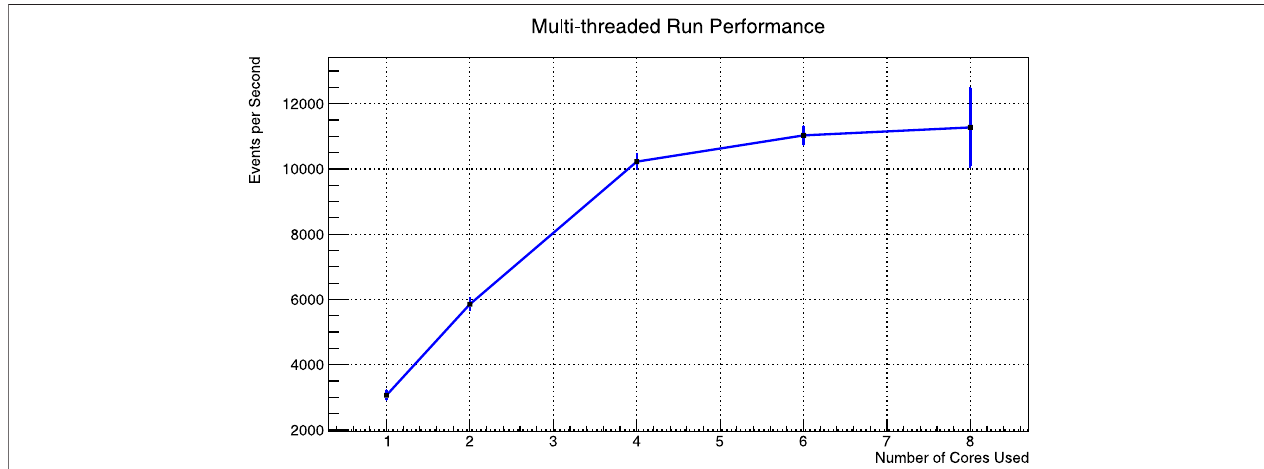
FIGURE3| Eventsprocessedpersecondwhenanalysisisdividedinto1,2,4,6and8threadsforvaryingnumberofevents.Errorbarsaremultipliedby10tomake them visible.